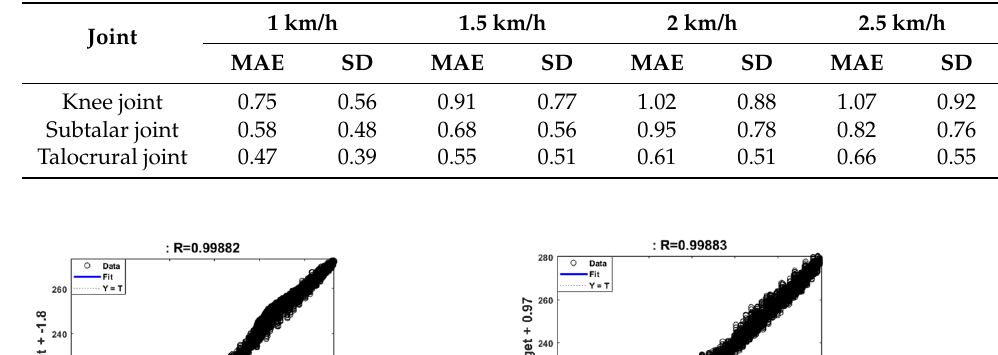
Table 4. The mean absolute error (MAE) and standard deviation (SD) of the angle estimation simulation according to walking speed.